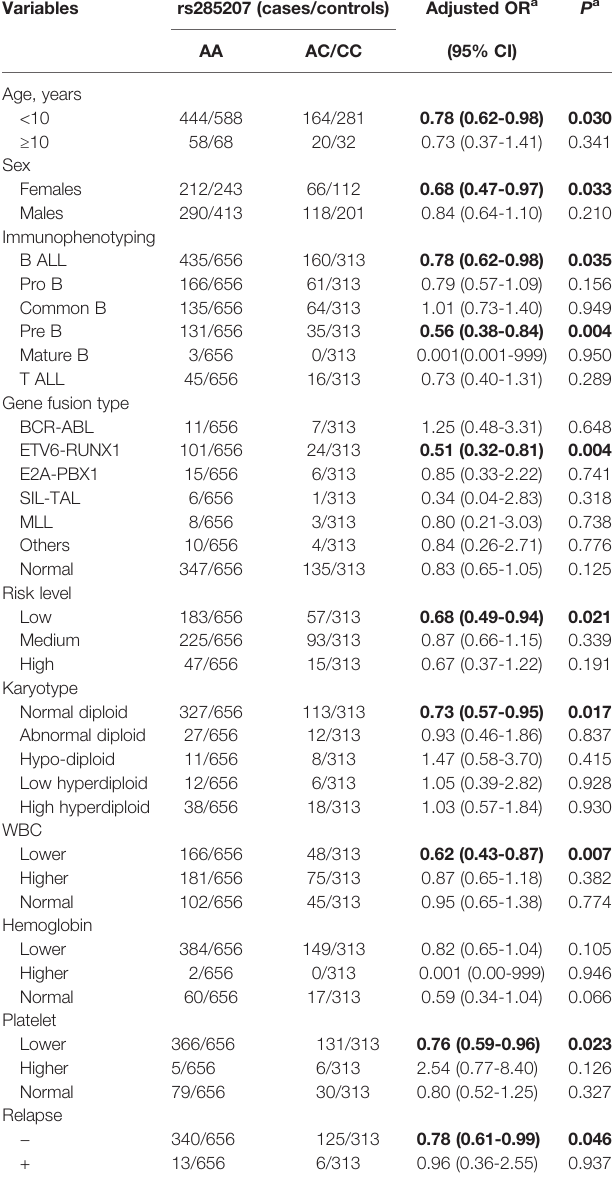
TABLE 4 | Subgroup and strati fi cation analysis of MYBL2 polymorphisms with ALL susceptibility. Variables rs285207 (cases/controls) Adjusted OR